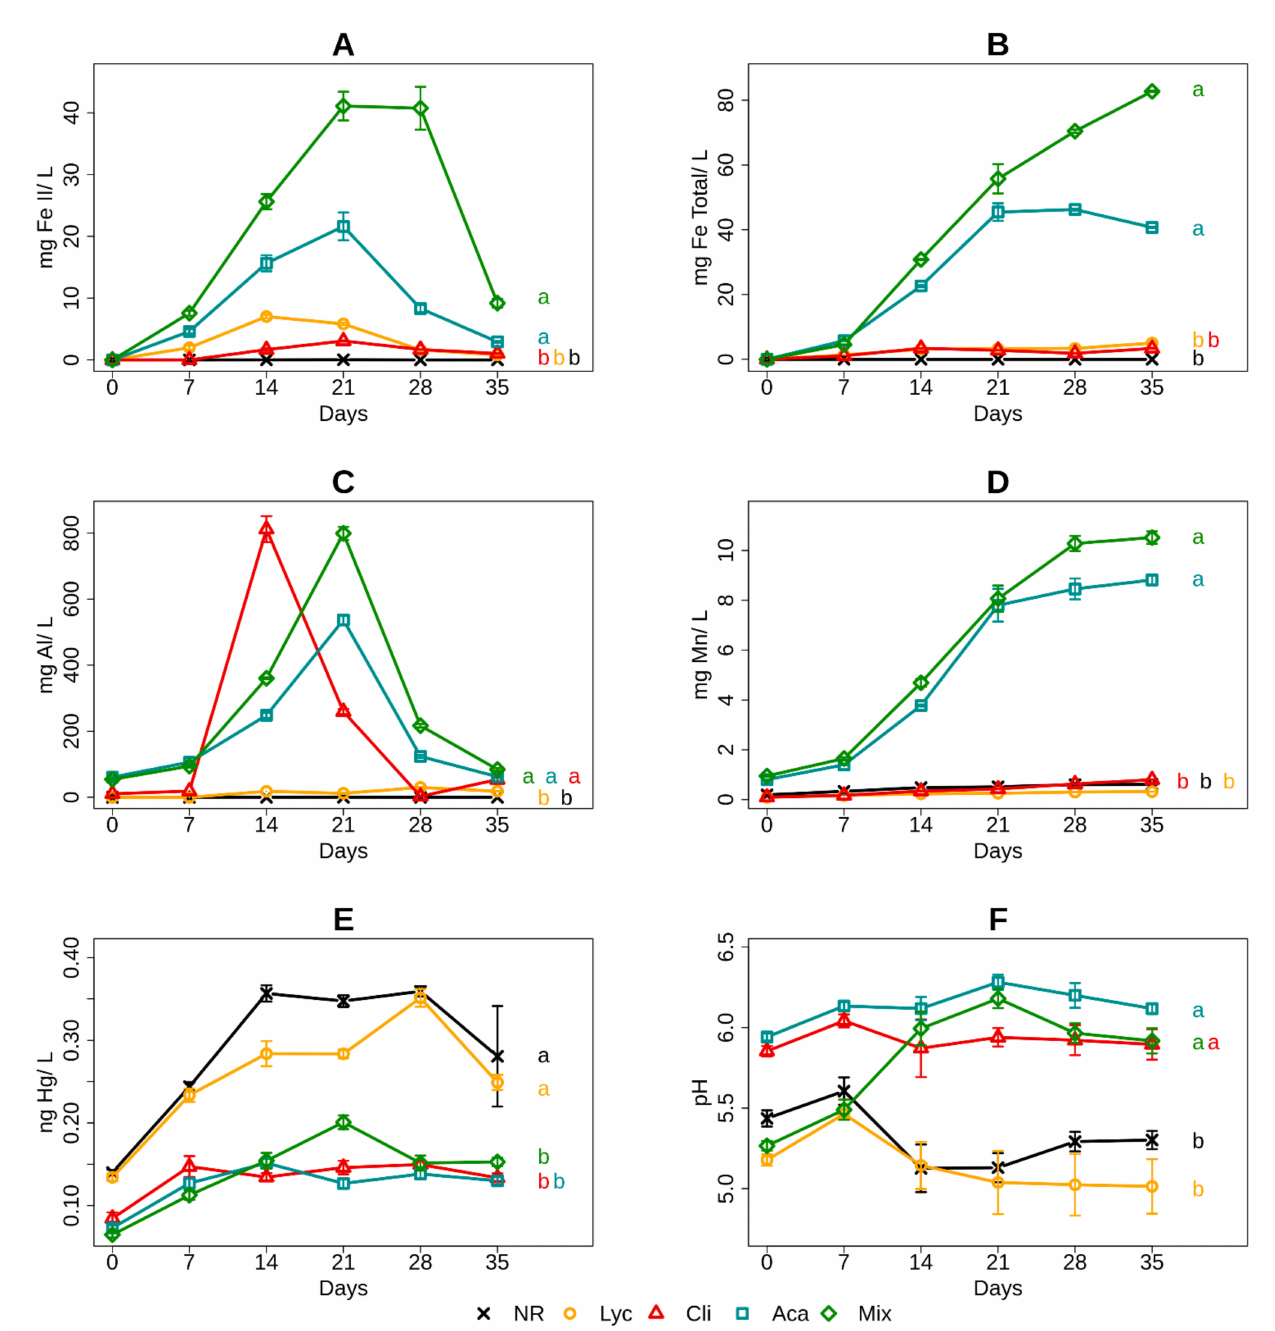
Figure 4. Fe(II) ( A ), total iron ( B ), Al ( C ), Mn ( D ), Hg ( E ) concentrations and pH ( F ) during 35 days of anaerobic incubation in the five sites ( n = 5, mean ± SD). For each site and at the end of each curve, an indicator letter has been added. Different letters (a,b,c,d) between sites indicate significant differences with p < 0.05 in the evolution of the measured parameter over time, obtained by repeated-measures ANOVA at the 5% critical